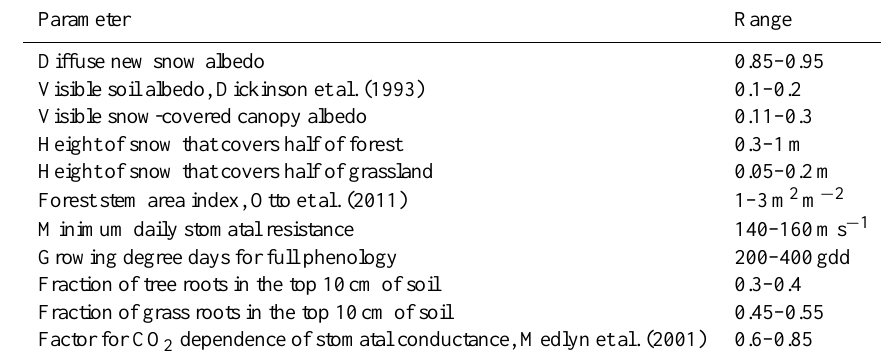
Table 2. Range of parameter values for different parameters affecting the biogeophysical processes included in the model